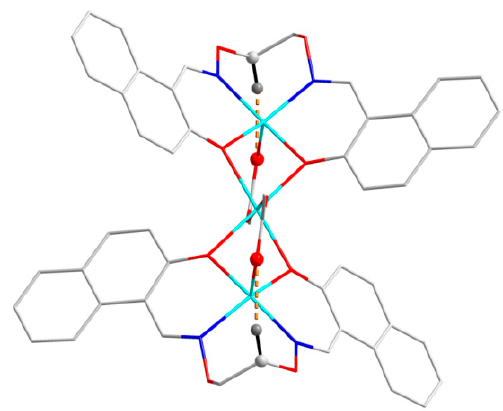
Figure 8. Part of 3D supramolecular network structure in 1 .